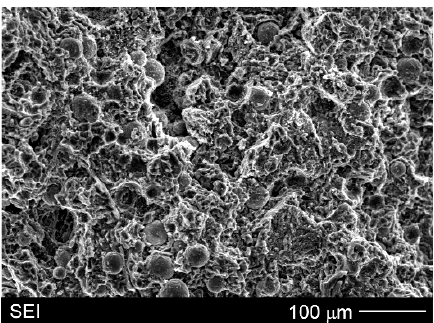
Figure 9. ( a ) Representative tension and compression curves for AZ91/(SiC + Ti) p hybrid composite; ( b ) Ultimate tensile strength (UTS), yield strength (TYS), compression strength (CS) and yield strength under compression (YS) of AZ91/(SiC + Ti) p hybrid composite compared with unreinforced AZ91 matrix alloy.